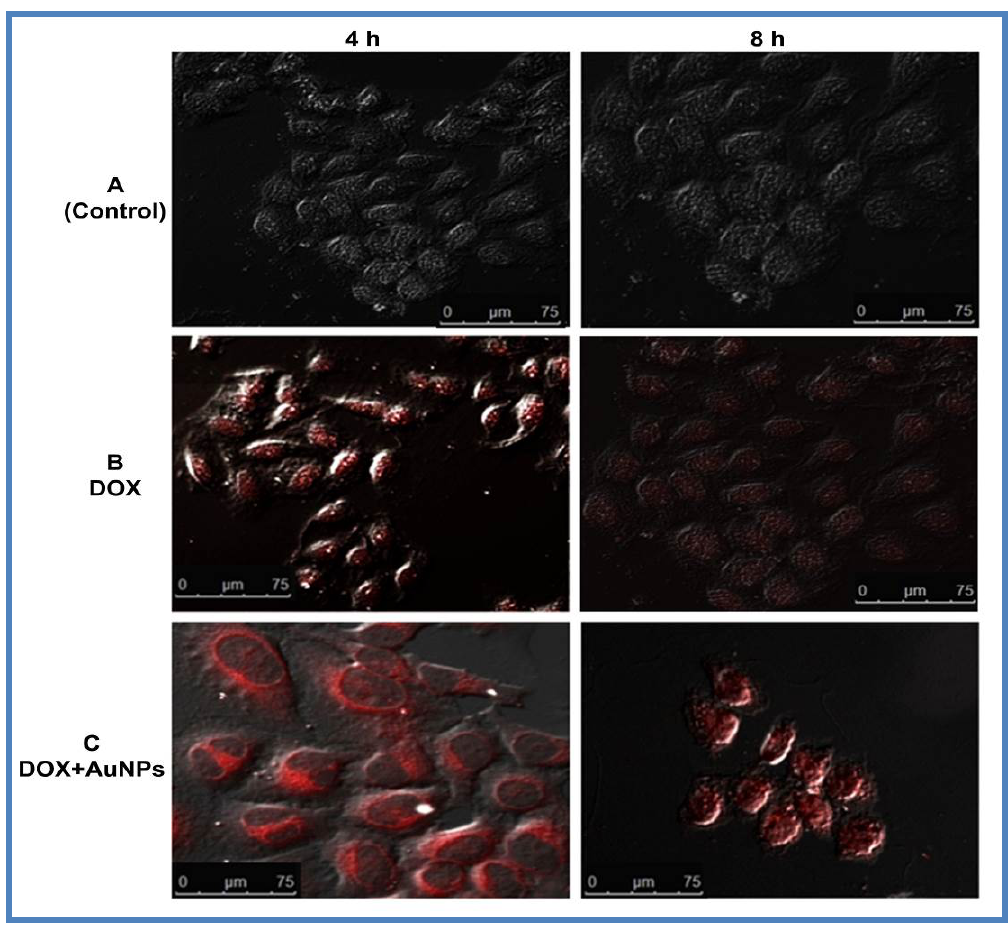
Figure 7. Confocal microscopy images depicting intracellular/nuclear localization of DOX in HeLa cells. HeLa cells were treated with 10 µg/mL DOX and DOX loaded AuNPs for 4 and 8 h followed by confocal imaging with Leica TCS SP5-II microscope at 200× magnification to interpret the cellular localization of DOX, scale 75 µm. ( A ) Control HeLa cells; ( B ) HeLa cells treated with DOX; and ( C ) and DOX loaded AuNPs. Data is representative of three independent